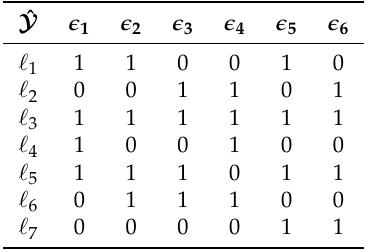
Table 12. Level Soft Set L ( ˆ Γ ; med ) .